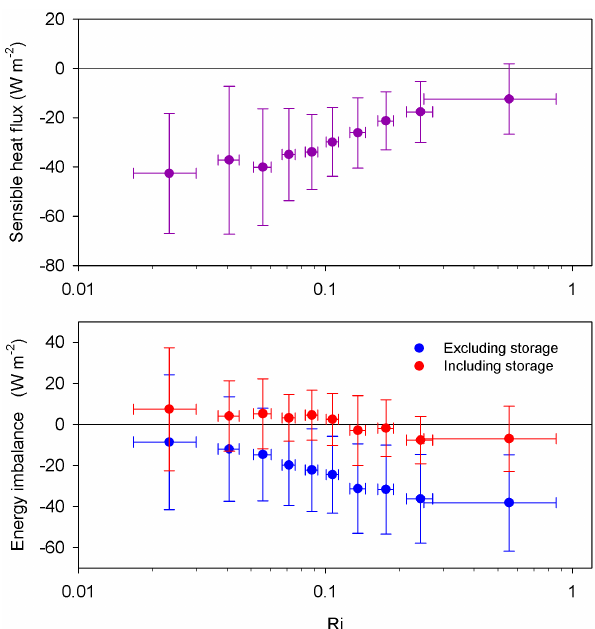
Fig. 10. Binned averages of sensible heat fluxes (top) and energy imbalance with and without storage (bottom) versus the Richadson number during unstable conditions. Data from the whole period June–July 1995. Data points representing extreme stabilities have been